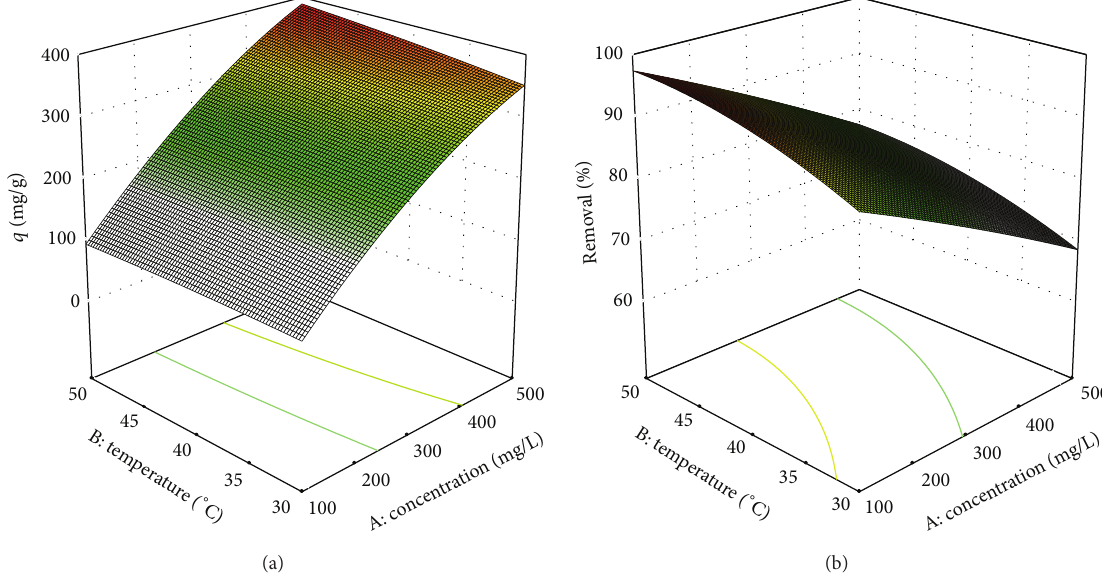
Figure 3: Three-dimensional response surface graphs: (a) combined effects of TB AGLF concentration and temperature on the adsorption capacity of sunflower pulp and (b) combined effects of TB AGLF concentration and temperature on percent TB AGLF removal by sunflower pulp.